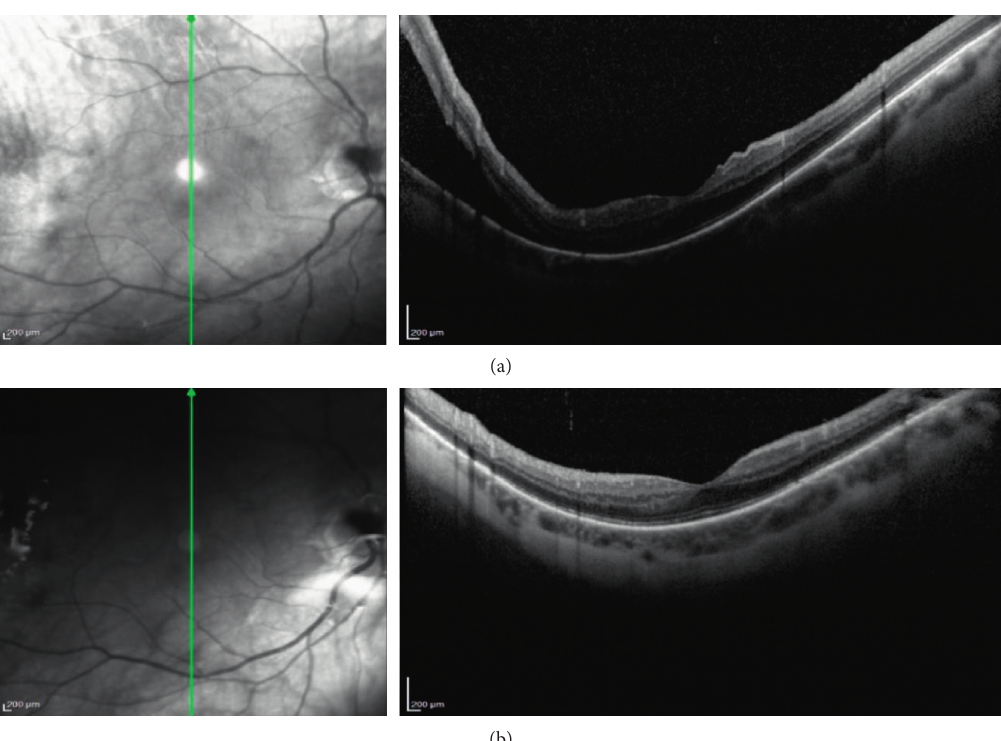
Figure 1: Preoperative SD-OCTimage (a) and six weeks’ postoperative SD-OCTimage (b) obtained after macula-on RRD surgery. Despite the proximity of the subretinal fluid to the macula (a), the anatomical reattachment of the retina without macular changes (b) demonstrates that the modified surgical procedure used in this study to treat uncomplicated RRD is